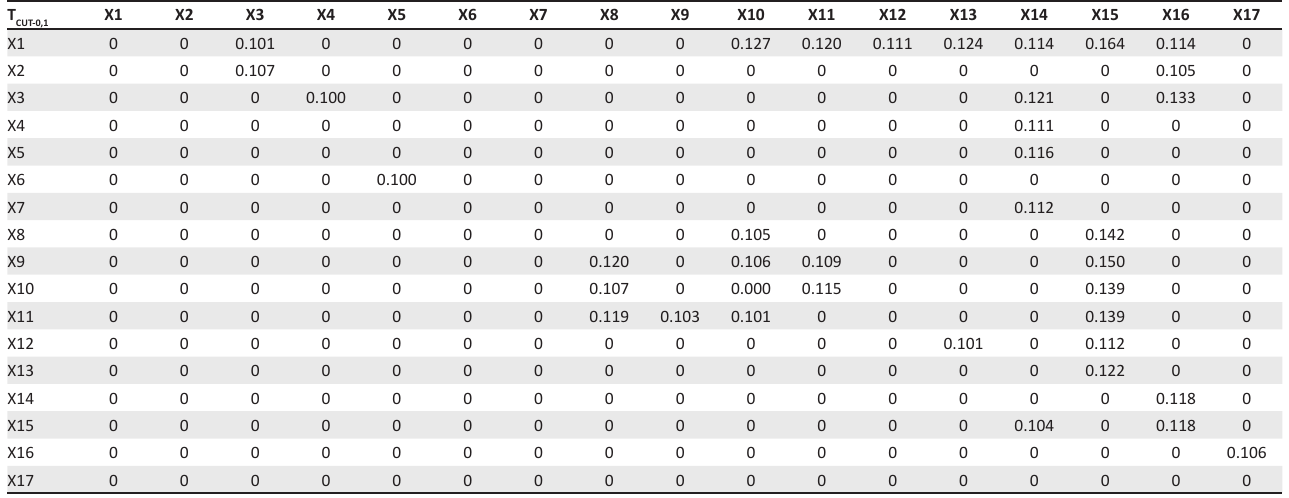
TABLE 2: Total-relation matrix of Technology Acceptance Model